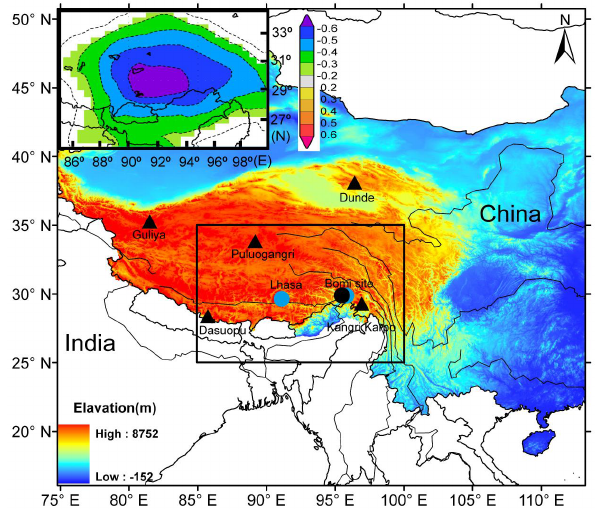
Fig. 1. Map of the study area and location of sites: tree ring sam- pling site (black circles), Bomi and Lhasa meteorological stations (blue circles), glacier ice core drilling sites (black triangles). The shading depicts the local topography. The subplot in the top-left corner shows the inter-annual correlation coefficients between Bomi tree-ring cellulose δ 18 O and the regional CRU cloud data (25 ◦ N– 35 ◦ N 85 ◦ E–100 ◦ E, rectangular in the map); contours are displayed for increments of the correlation coefficients ( p < 0.05, n =46). The cloud data were obtained from CRU version 2.0 (New et al., 1999, 2000).